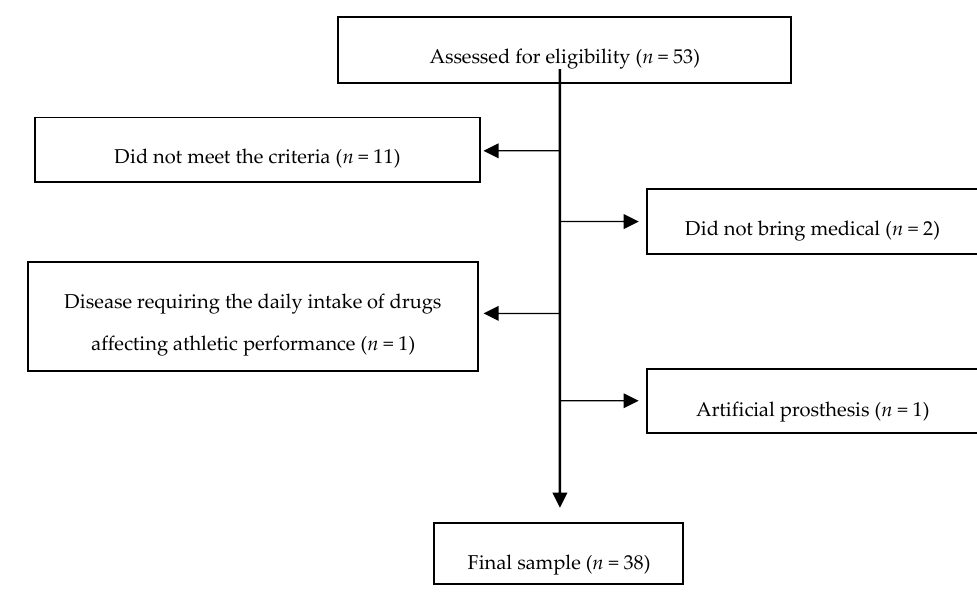
Figure 1. Flowchart of the participants.